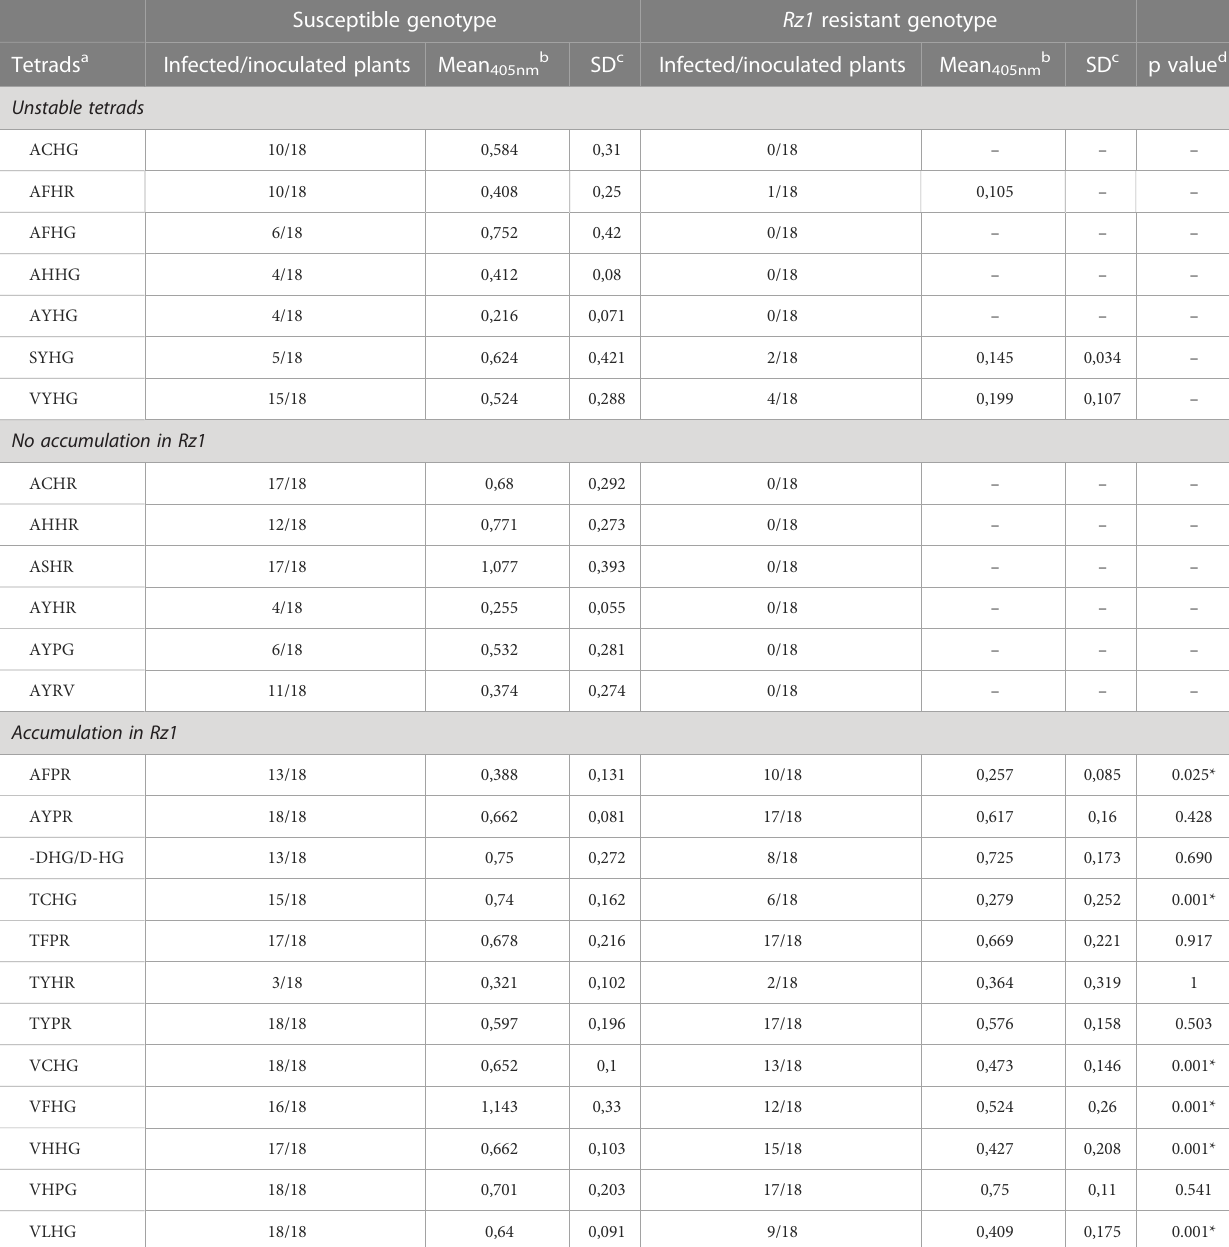
TABLE 1 Effect of different P25 tetrads (aa67-70) on BNYVV accumulation of in a susceptible and Rz1 resistant